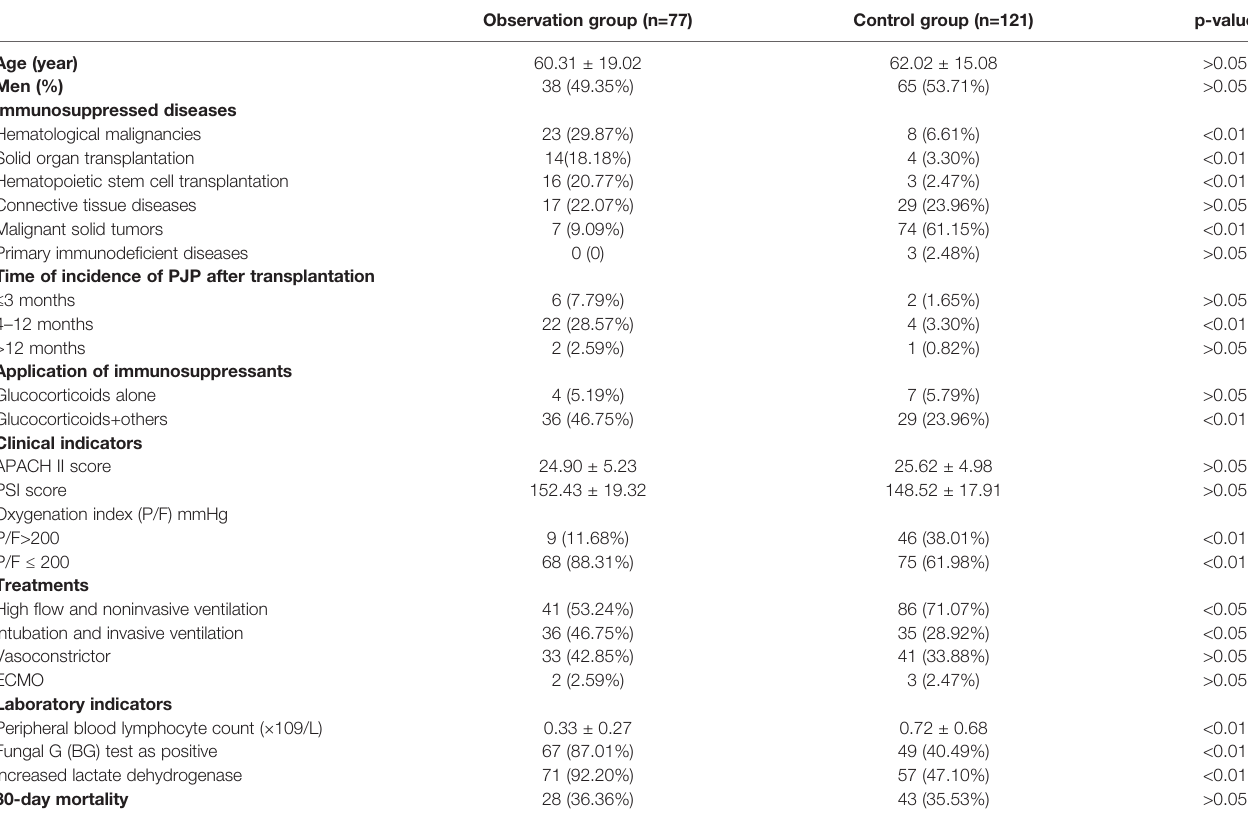
TABLE 1 | The basic clinical data of enrolled